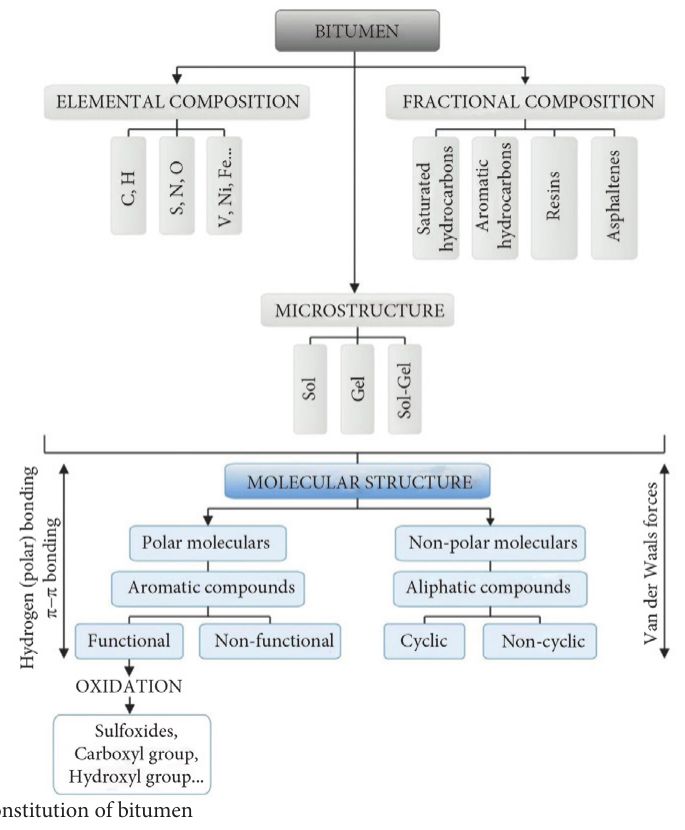
fig. 3. A basic scheme of the constitution of bitumen